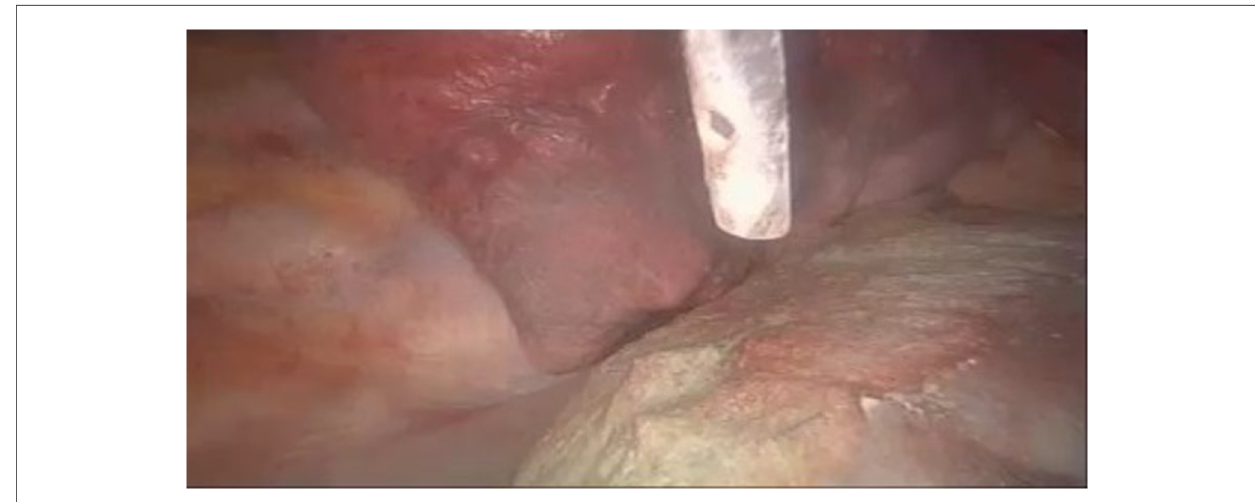
FIGURE 7 VATS chemical pleurodesis, nebulizing sterile medical talc powder on the pleura, to minimize the risk of CP recurrence. VATS, video-assisted thoracic surgery; CP, catamenial